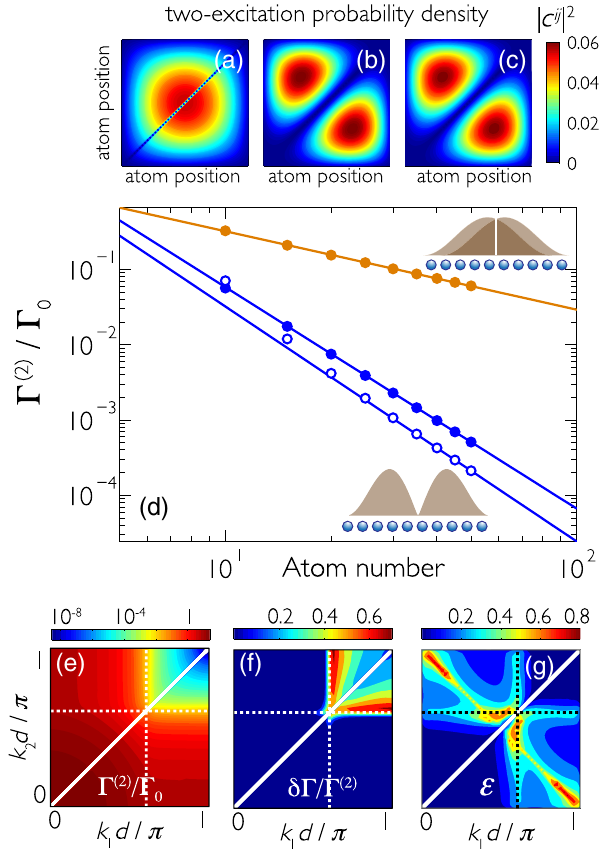
FIG. 9. Two-excitation collective modes in a 1D chain of two- level atoms with polarization parallel to the chain. Probability j c ij j 2 of atoms i and j to be excited (with c ii ¼ 0 ) for (a) state resulting from occupying the most subradiant single-excitation mode twice, i.e., ð S † ξ Þ 2 j g i ⊗ N , (b) most subradiant mode c ij ξ ¼ 1 ¼ 1 (obtained by exact diagonalization), (c) fermionic ansatz c ij ans . The two axes denote the excited atoms position ( i and j ). (d) Scaling of the collective decay Γ ð 2 Þ with atom number corresponding to the states (a) (orange circles), (b) (blue open circles), and (c) (blue solid circles). The lines are polynomial fits (to the last five points), close to ∼ 1 =N (a) and ∼ 1 =N 3 (b),(c). (e) Decay rates as a function of the associated pair of quasimomentum values ð k 1 ; k 2 Þ of the two excitations (by construction k 1 ≠ k 2 ). Subradiant states arise when both k 1 ; k 2 > k 0 , where k 0 corresponds to the light 2 Þ − Γ ð 2 Þ j = Γ ð 2 Þ line (dotted lines). (f) Relative error δ Γ = Γ ð 2 Þ ¼ j Γ ð sum between the numerically exact decay rate and the decay rate 2 Þ estimated from the sum of single-excitation decay rates Γ ð sum . (g) Error in overlap between exact and antisymmetrized ansatz. In all plots N is fixed to 50 atoms [except (d)] and d= λ 0 ¼ 0 . 3